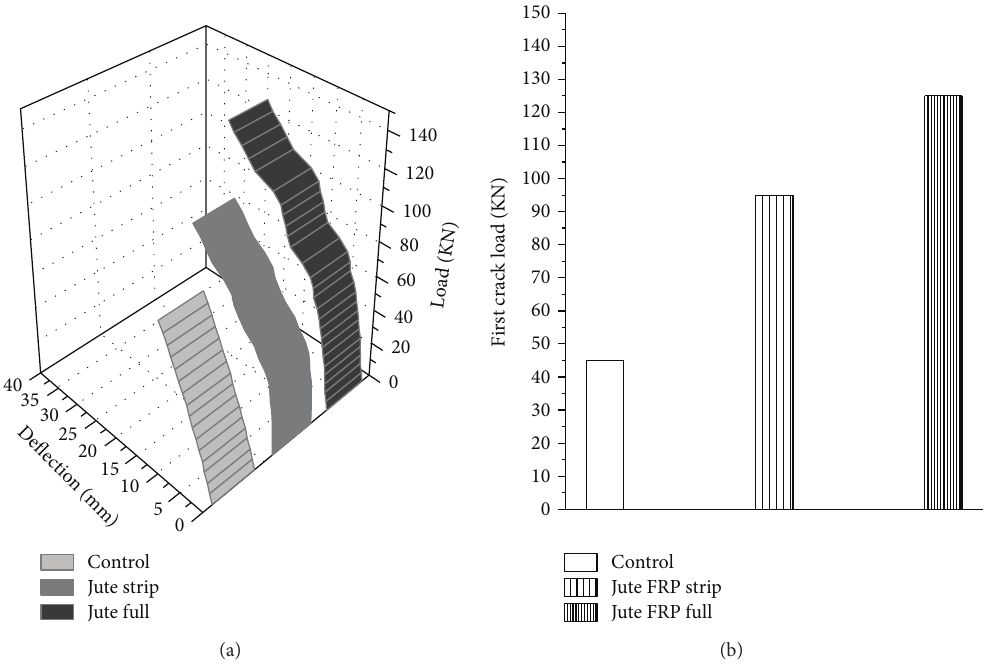
Figure 9: (a) Comparison of ultimate load carrying capacity of all beams; (b) comparison of first crack load of all